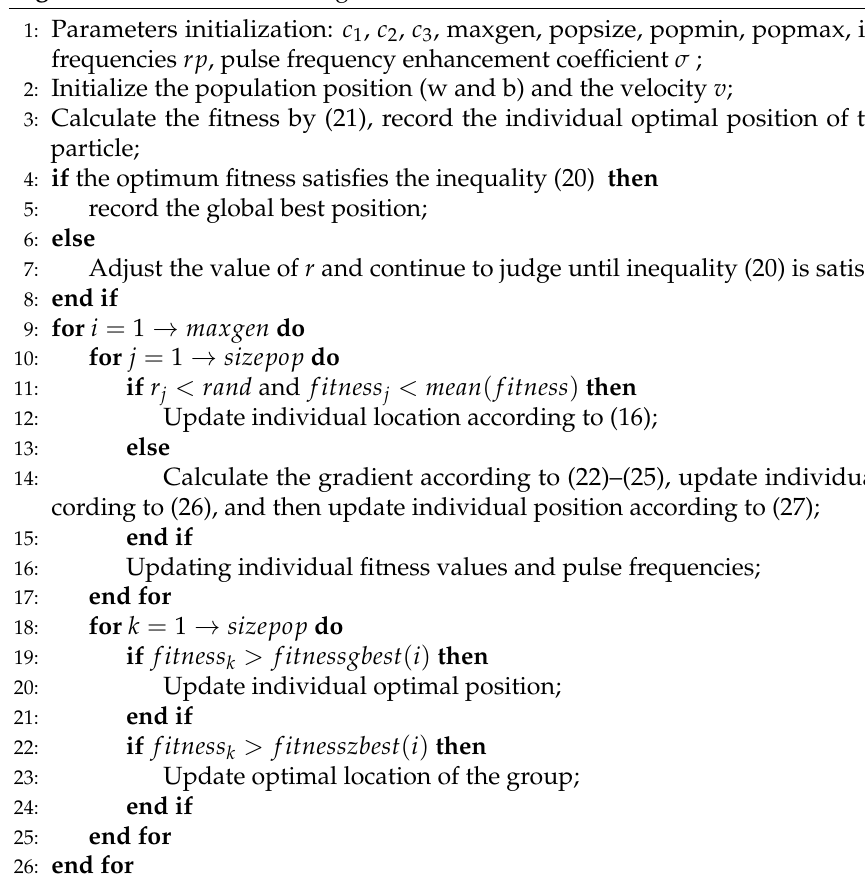
Algorithm 1 The G-BAPSO algorithm